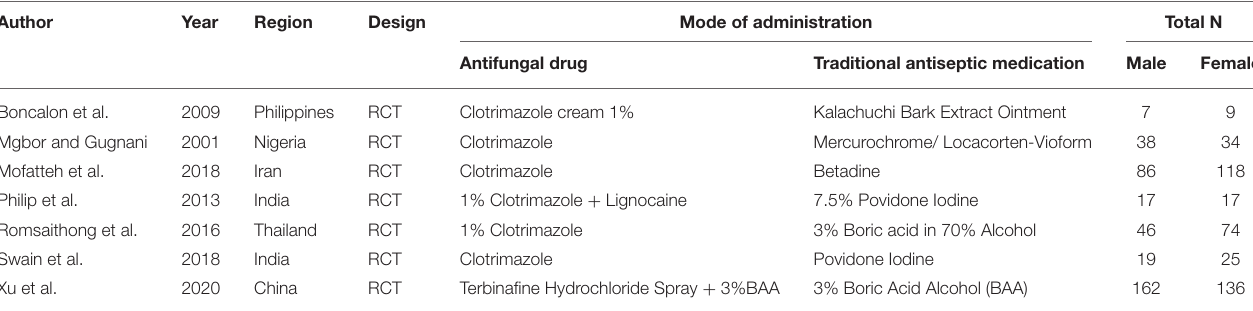
TABLE 1 | Study characteristics and details of interventions.